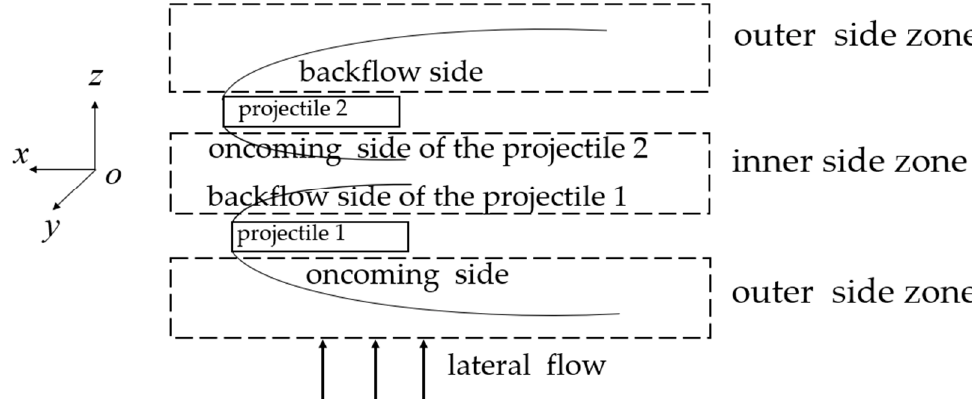
Figure 8. Schematic diagram of the definition of different zones in the flow field.